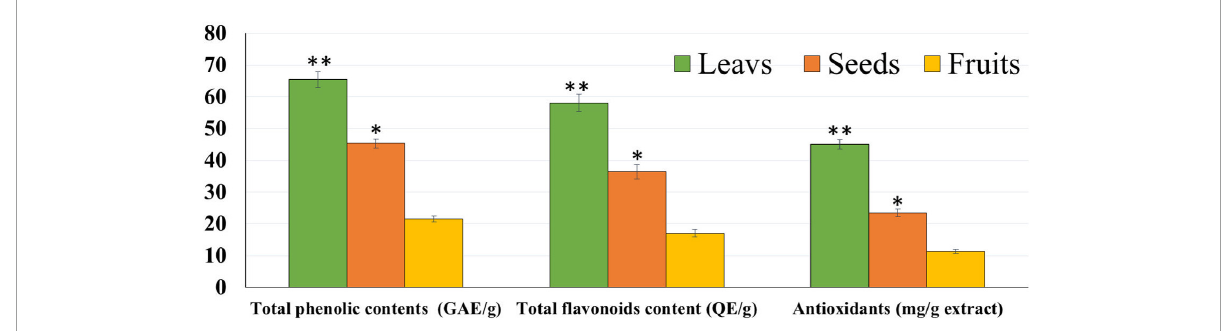
FIGURE1 Total phenolic contents, flavonoid, and antioxidants of leaf, seed, and fruit ethanolic extracts. The highest antioxidant potential was observed with leaf extract followed by seed and fruit extracts. * P -value was considered statistically significant ( P < 0.05) and ** P -value was considered highly significant ( P <